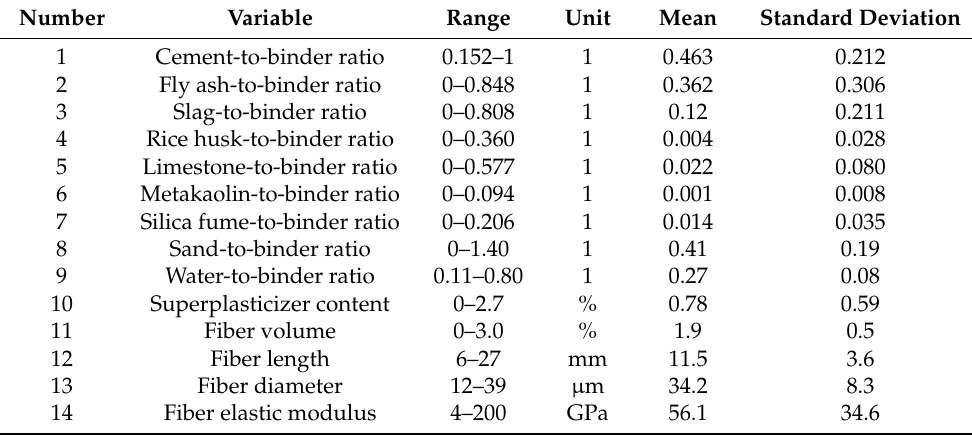
Table 1. Description of input